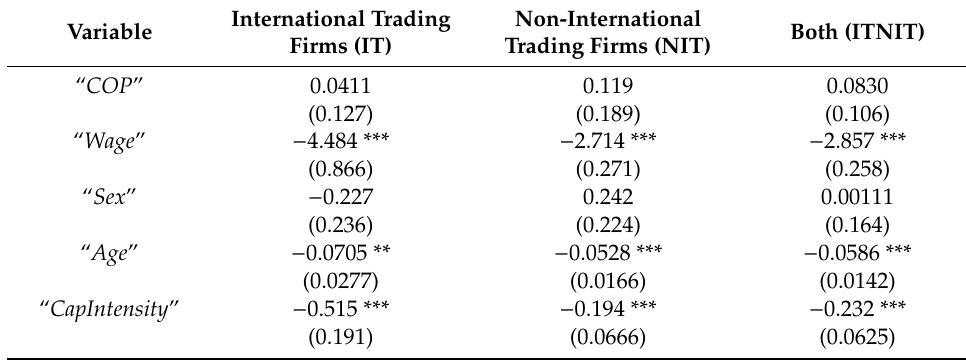
Table 5. Regression results for export-import